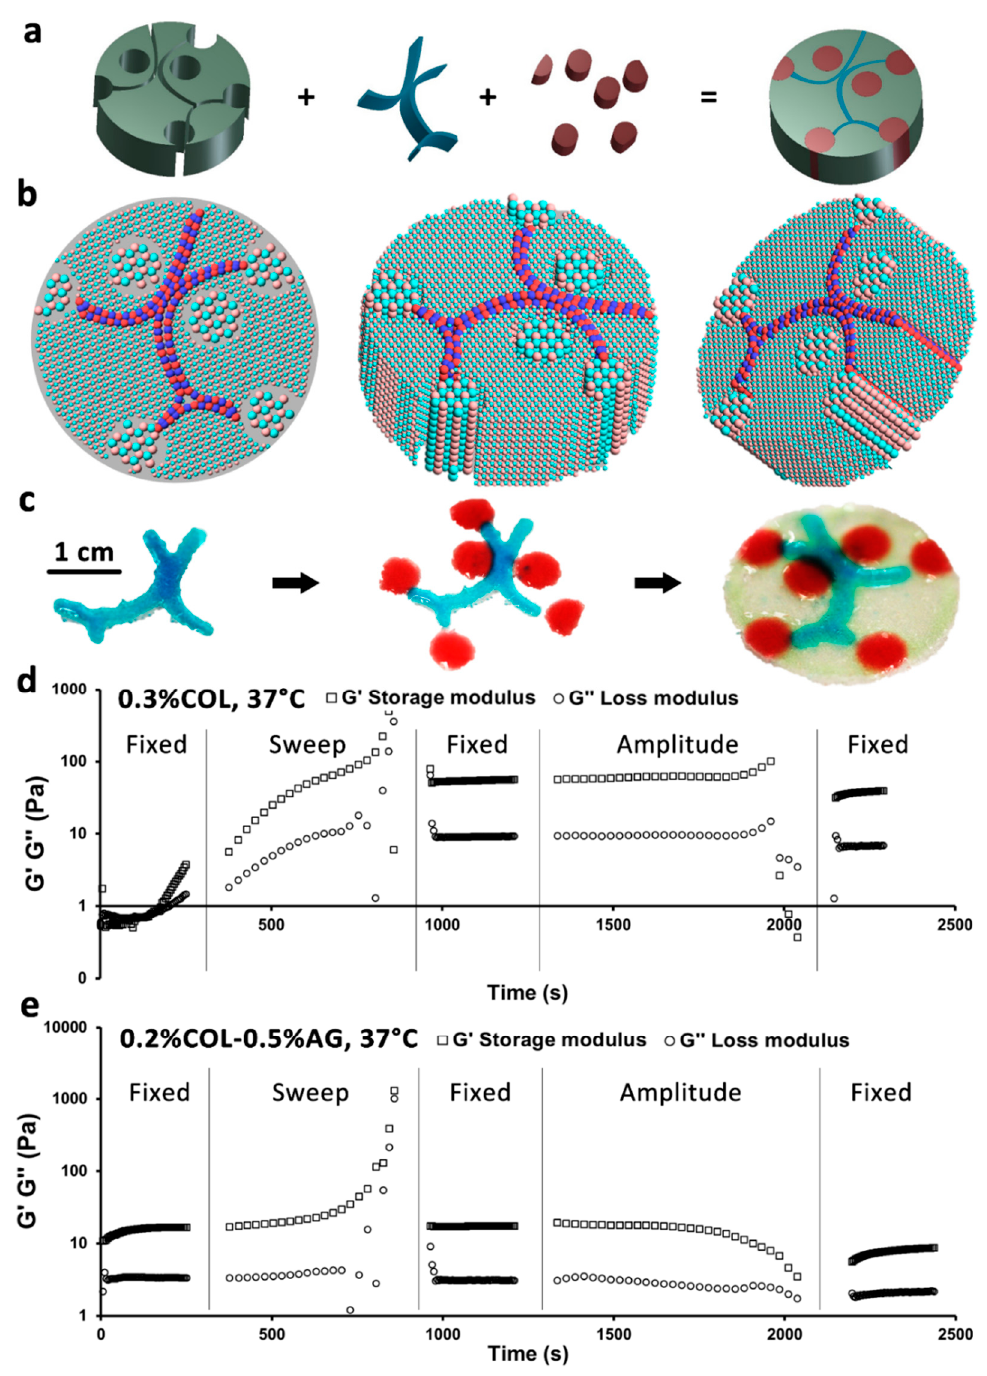
Figure 2. Printability study of bioinks and proof-of-concept printing of a 3D cancer model. ( a ) CAD design of 3D model, ( b ) its sliced version, and ( c ) macroscopic outcome after printing. Rheological measurement of ( d ) 0.3% COL and ( e ) 0.2% COL-0.5% AG with a 5-step oscillatory test. The nonrecovery of 0.3% COL structure after the frequency sweep test can be identified, in contrast to 0.2% COL-0.5% AG, which recovered its storage and loss moduli. G’ represents the storage modulus (squares) and G’’ represents the loss modulus (circles).